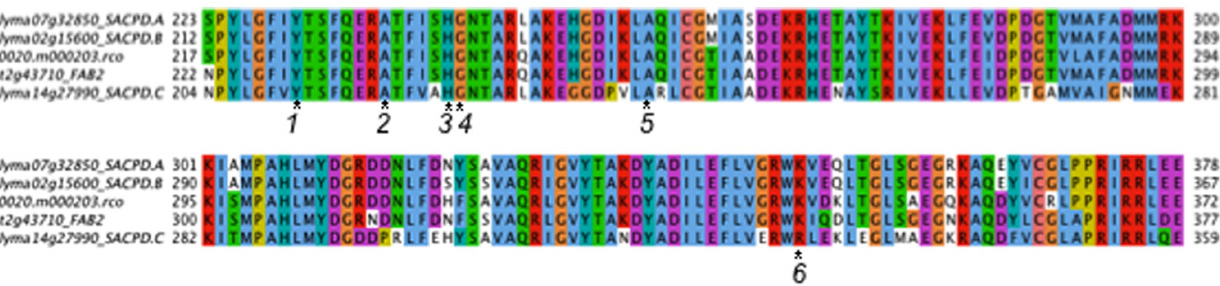
Figure 1. Mutations in the SACPD-C enzyme. Multiple sequence alignment for soybean SACPD-C with close sequence homologs showing the position of mutations in conserved locations. Other proteins shown are SACPD-A and SACPD-B from soybean, FAB2 from Arabidopsis (At3g02610/ DES2), and the castor bean SACPD (30020.m000203.rco). Mutations described in this work are located at the following positions: 1. SACPD-C Y211C 2. SACPD-C A218E 3. SACPD-C H223R 4. SACPD-C G224E 5. SACPD-C A239T 6. SACPD-C R329I .